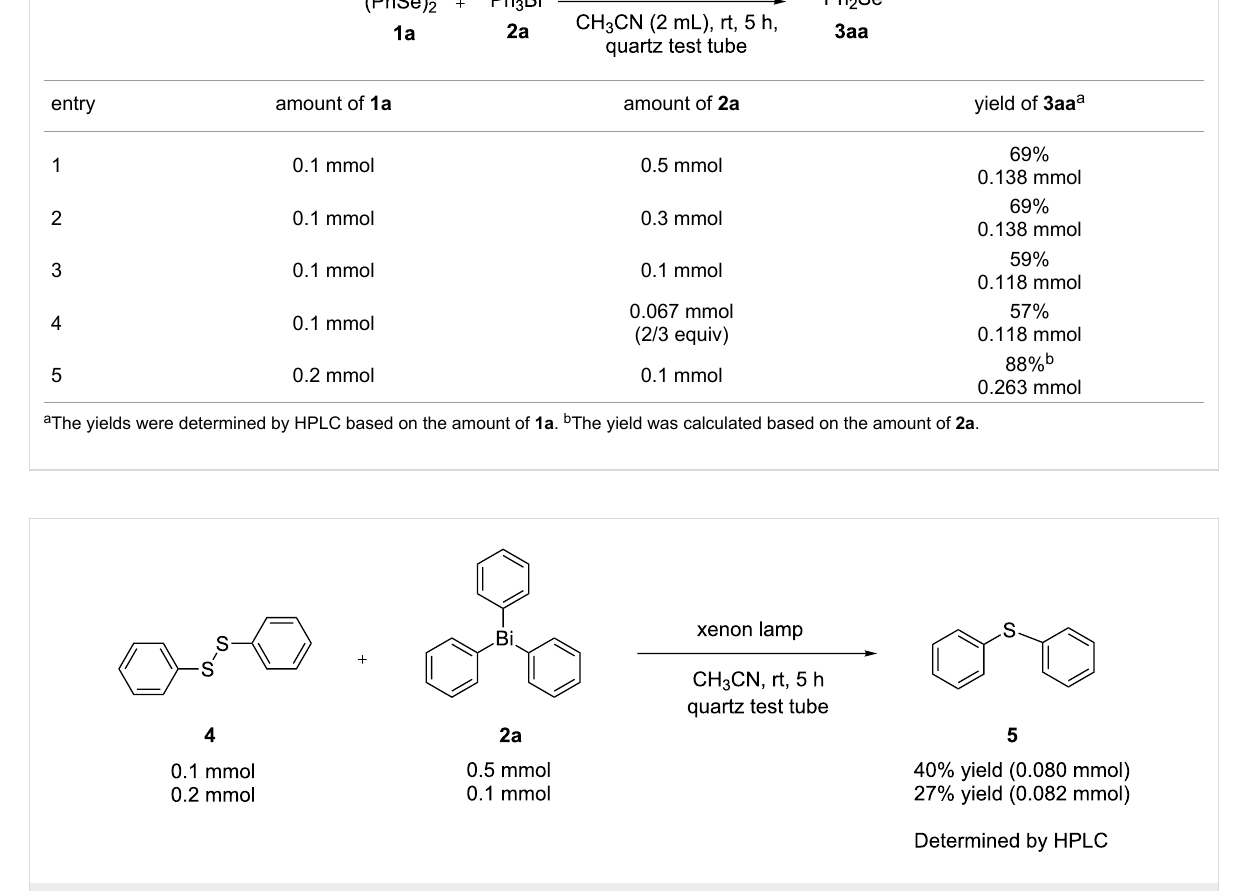
Table 3: The yield of diphenyl selenide 3aa upon changing the ratio 1a / 2a .